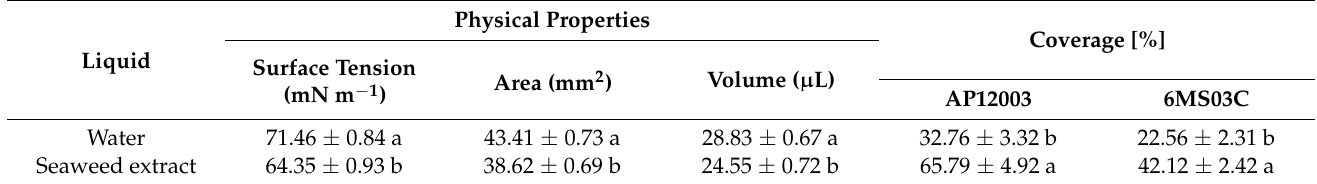
Table 1. Physical properties of the working liquid and plant